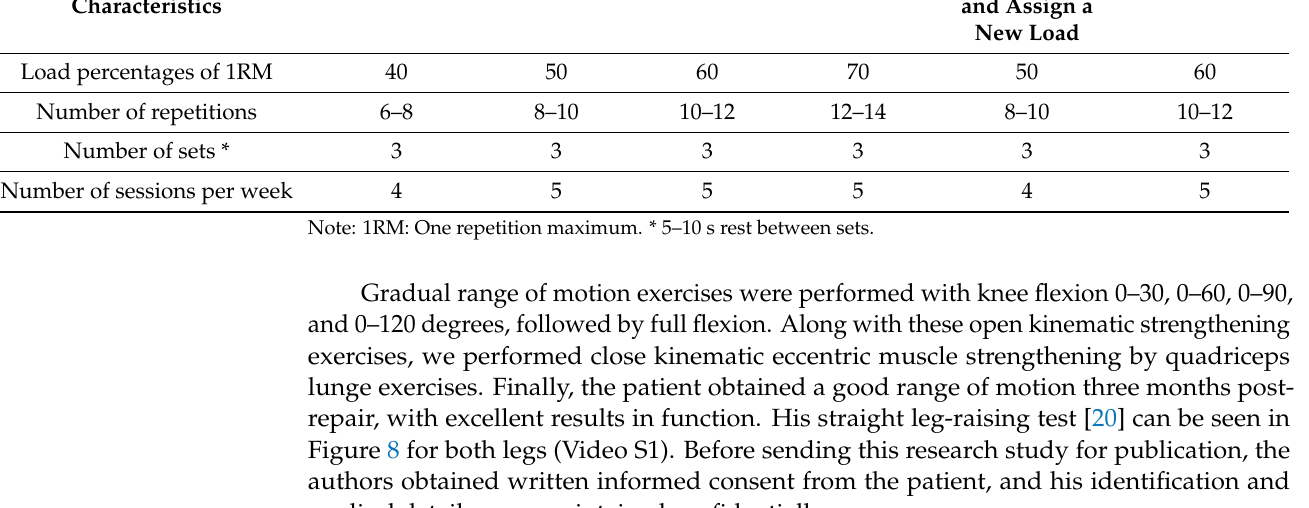
Table 1. Training details of the high sitting quadriceps and hamstrings resistance exercise.